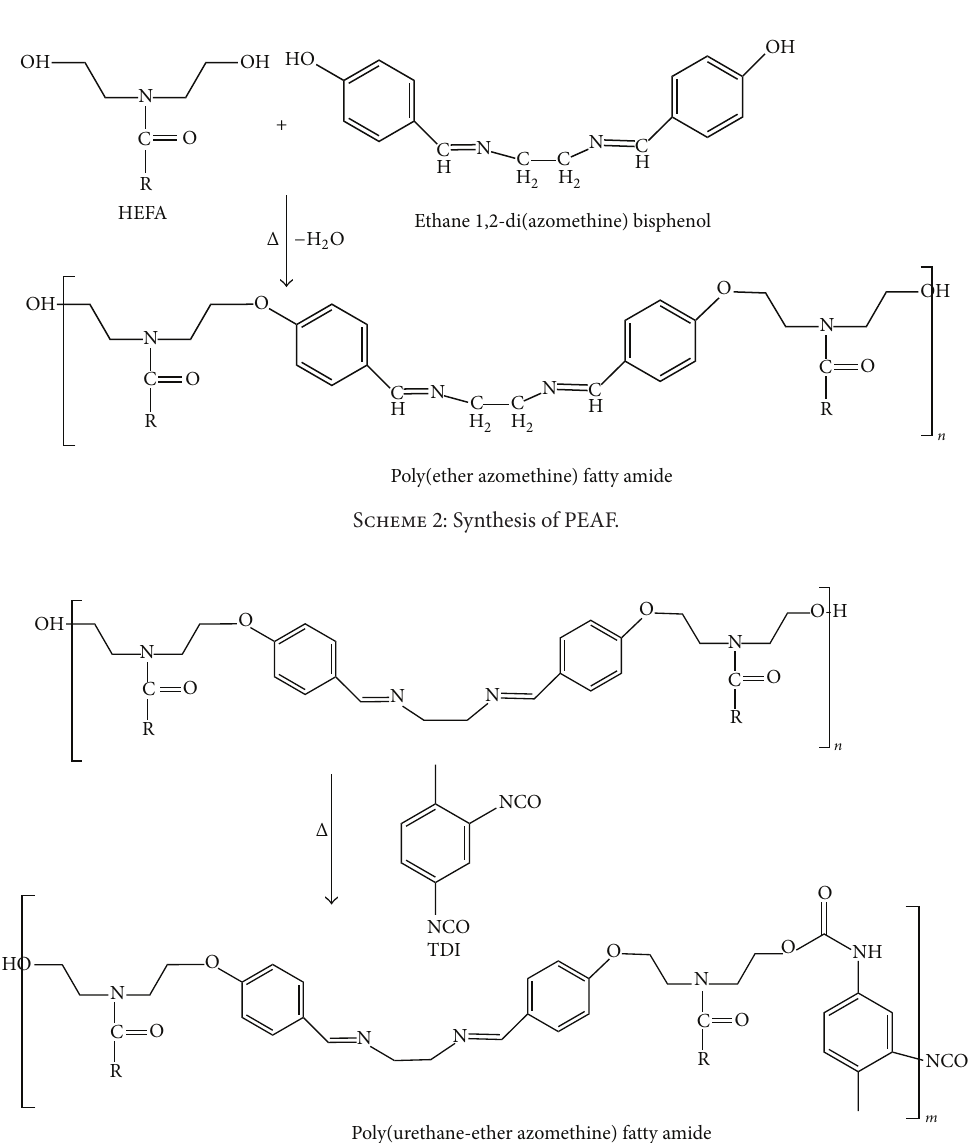
Scheme 3: Synthesis of